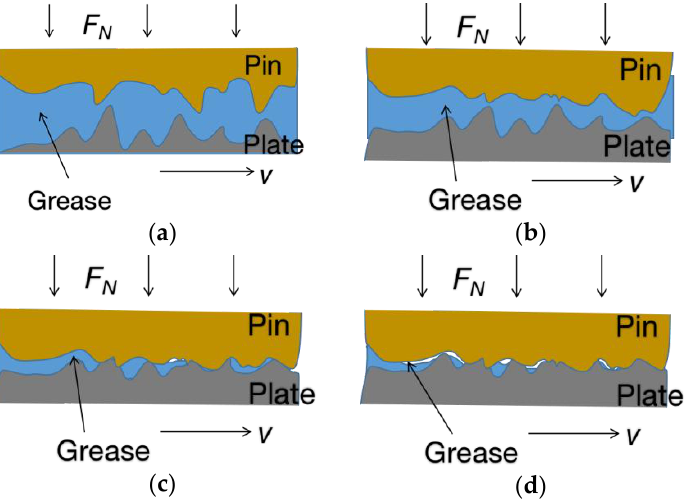
Figure 10. Schematic diagrams of the copper–steel tribo-pair under the lubrication of LCG grease as the function of wear time: ( a ) the beginning of the wear time, ( b ) the thickness of the grease decreased, ( c ) asperities contact and ( d ) the boundary lubrication period .